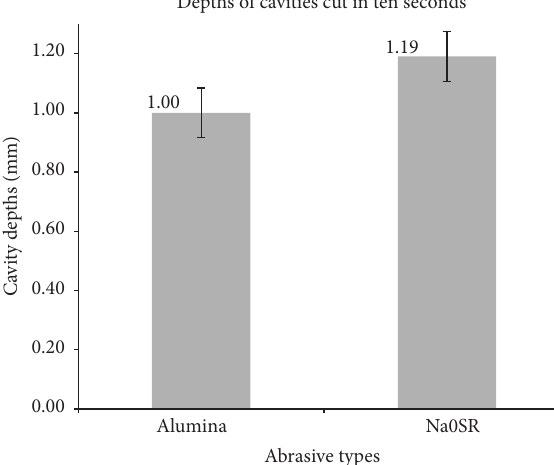
Figure 5: Comparison of cavity depths cut in 10 seconds between alumina and Na0SR